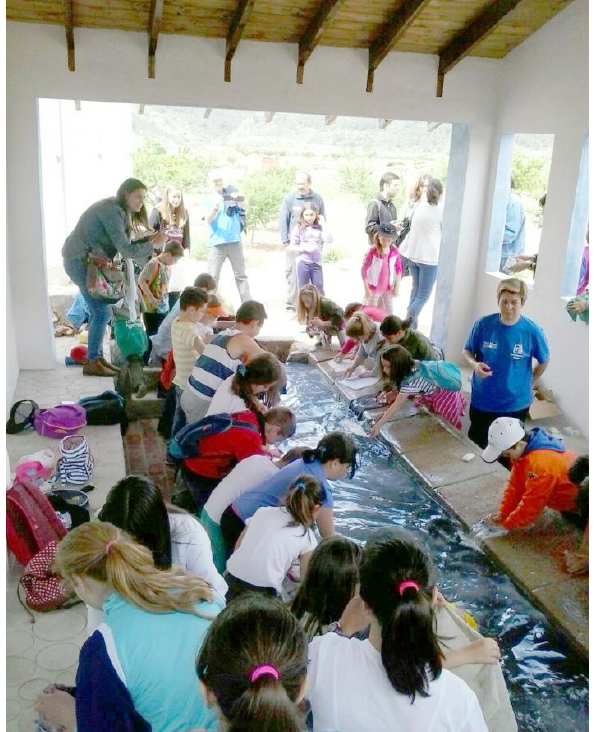
Figure 3. Social participation in the inauguration for the recovery of the wash houses of Tuéjar.